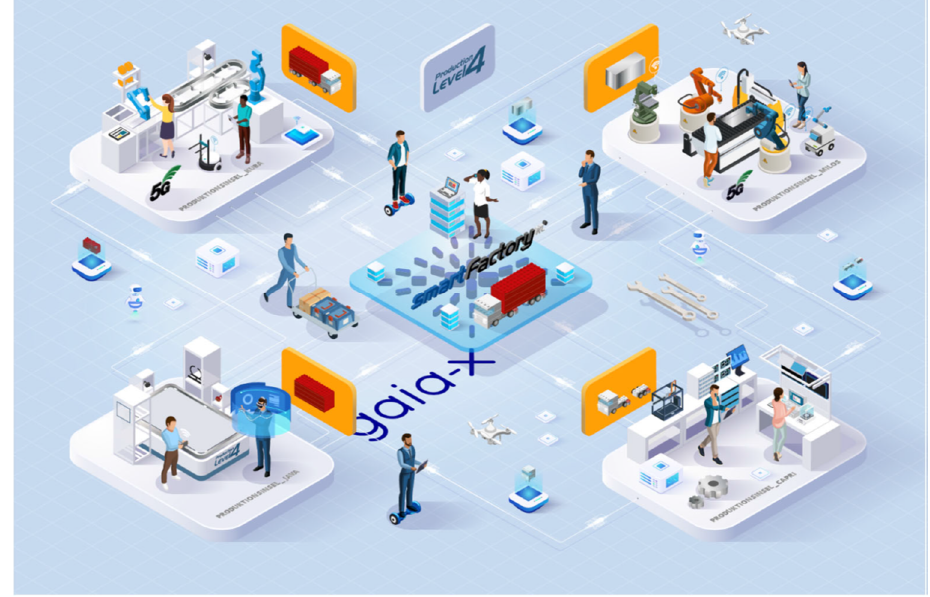
Figure 3. Industrie 4.0 in a smart factory (Source: SmartFactory KL and DFKI IFS).